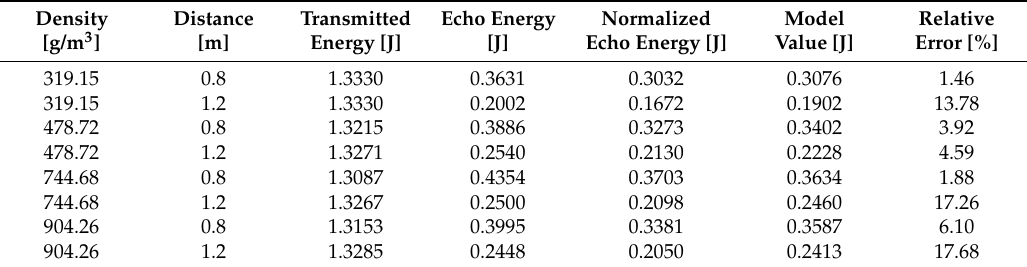
Table 9. Canopy density model universal analysis with 5 layers of leaves.